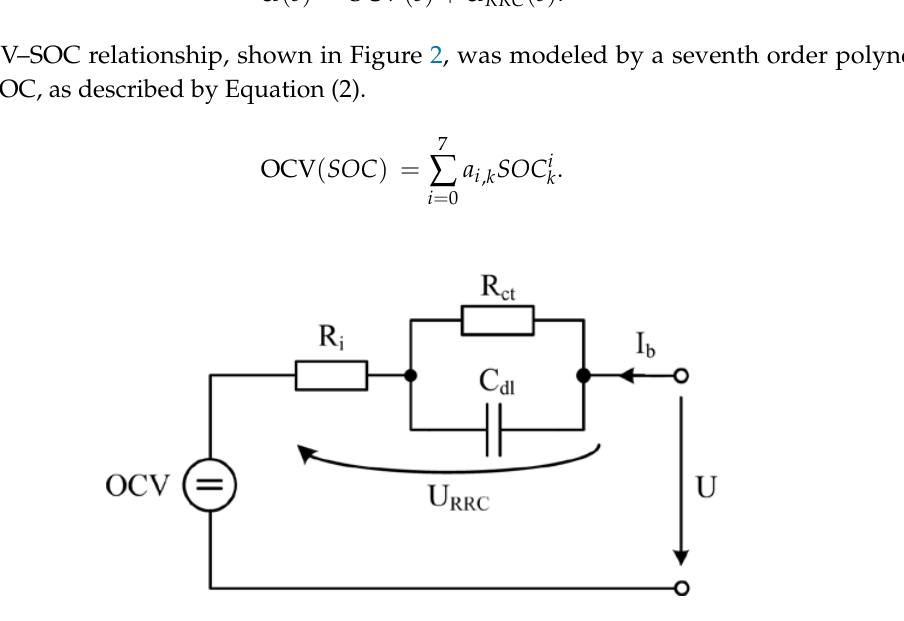
Figure 1. Equivalent circuit model of the lithium-ion battery.